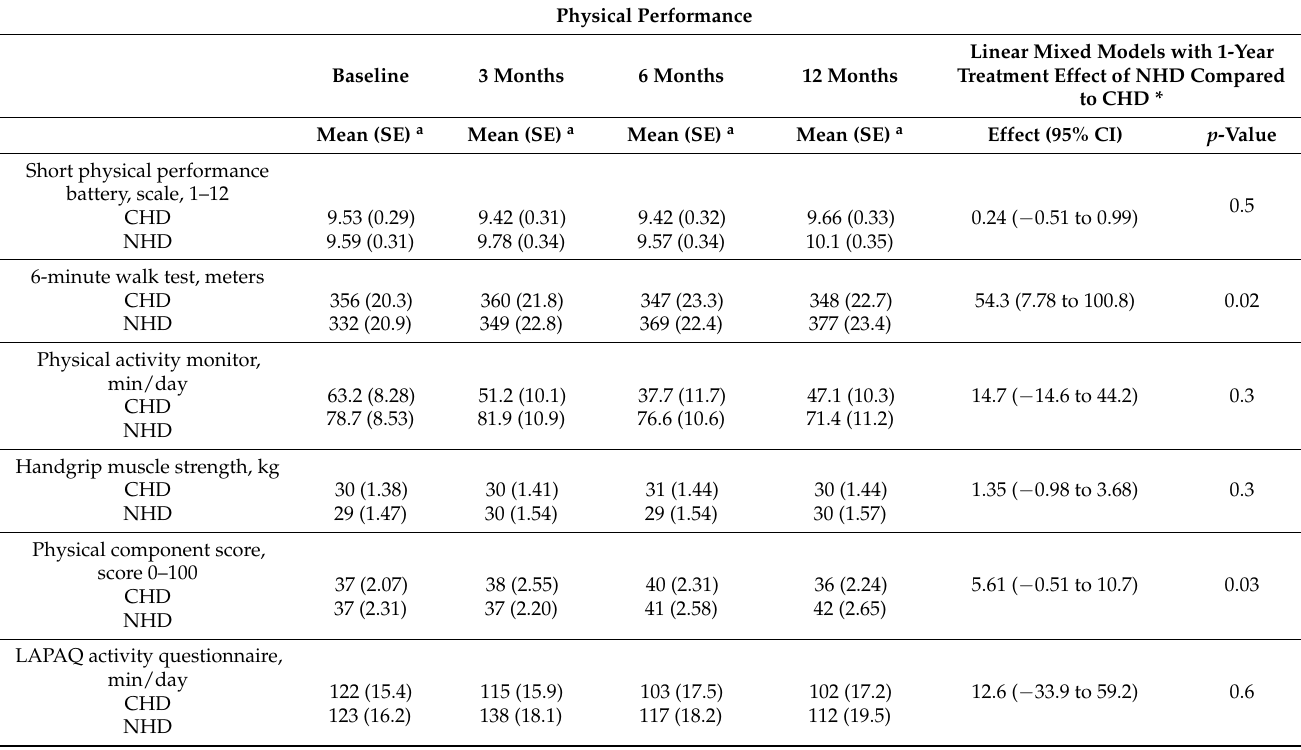
Table 3. Physical performance over 1 year in nocturnal hemodialysis patients compared to conven- tional hemodialysis